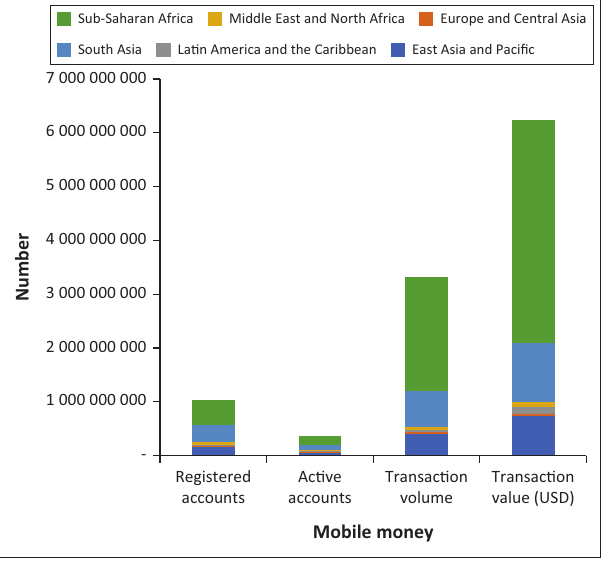
FIGURE 1: Global mobile